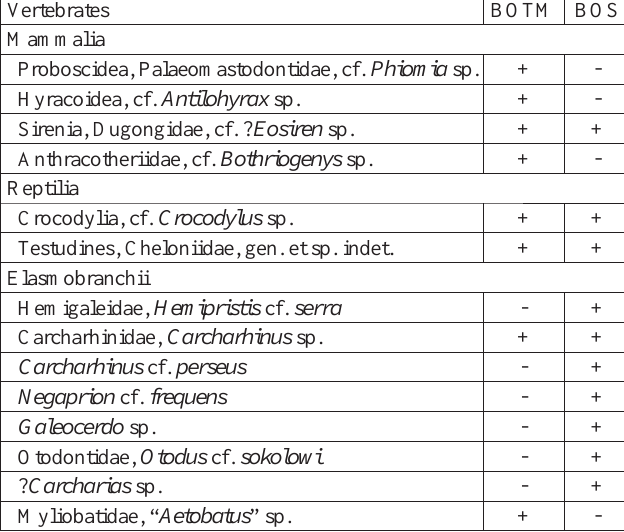
Table 4. Vertebrates from the BOTM and BOS, early Oligocene, Min- qar Tibaghbagh, Qattara Depression,